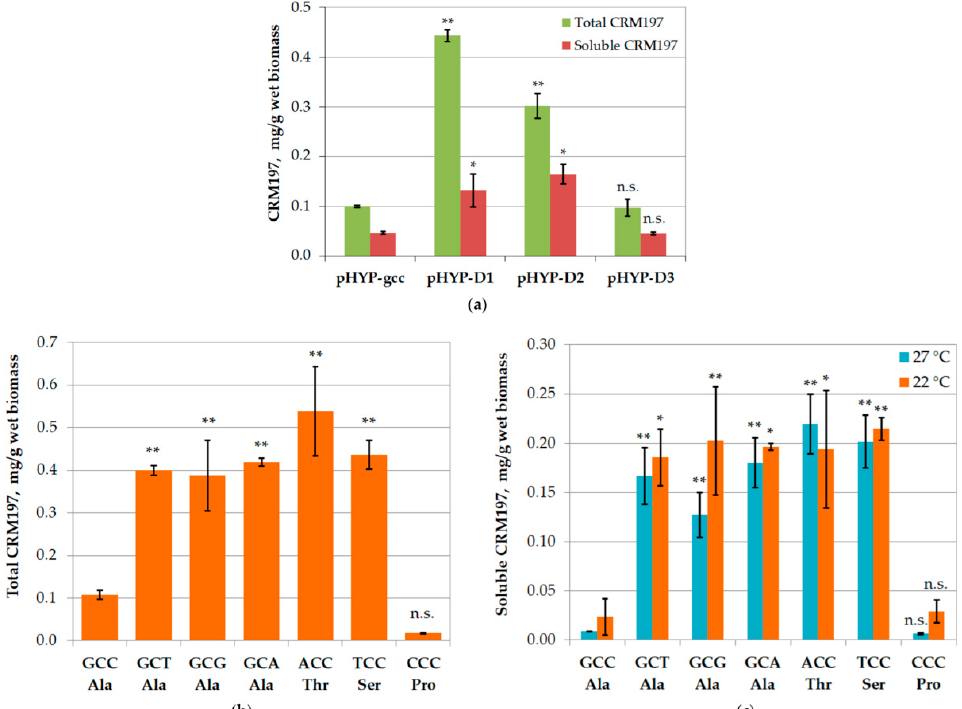
Figure 2. Effects of mutations in the beginning of the CRM197-encoding gene on the CRM197 expression level in the E. coli SHuffle T7 strain. ( a ) Short deletions. CRM197 levels after its overnight expression at 22 °C from the plasmids pHYP-D1, pHYP-D2, and pHYP-D3 in comparison with those from the pHYP-CRM197-gcc plasmid. ( b ) Point mutations. Levels of total (soluble + insoluble) CRM197 after its overnight expression at 22 °C from the plasmids pHYP-CRM197-gct, pHYP-CRM197-gca, pHYP-CRM197-gcg, pHYP-CRM197-acc, pHYP-CRM197-tcc, and pHYP-CRM197-ccc in comparison with that from the pHYP-CRM197-gcc plasmid. ( с ) Point mutations. Levels of soluble CRM197 after its overnight expression at 27 or 22 °C from the same plasmids as in panel ( b ). N = 2, *— p < 0.05; **— p < 0.01; n.s.— p > 0.05 (ANOVA, pairwise comparison with GCC).